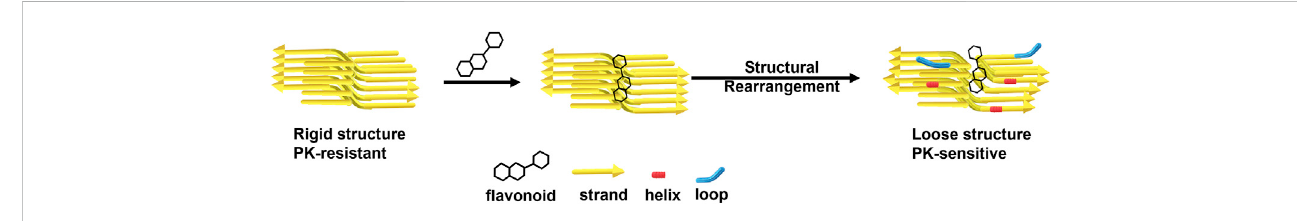
FIGURE 8 A representative scheme of fl avonoids disaggregates prion fi brils by decreasing β -sheets and increasing helices and